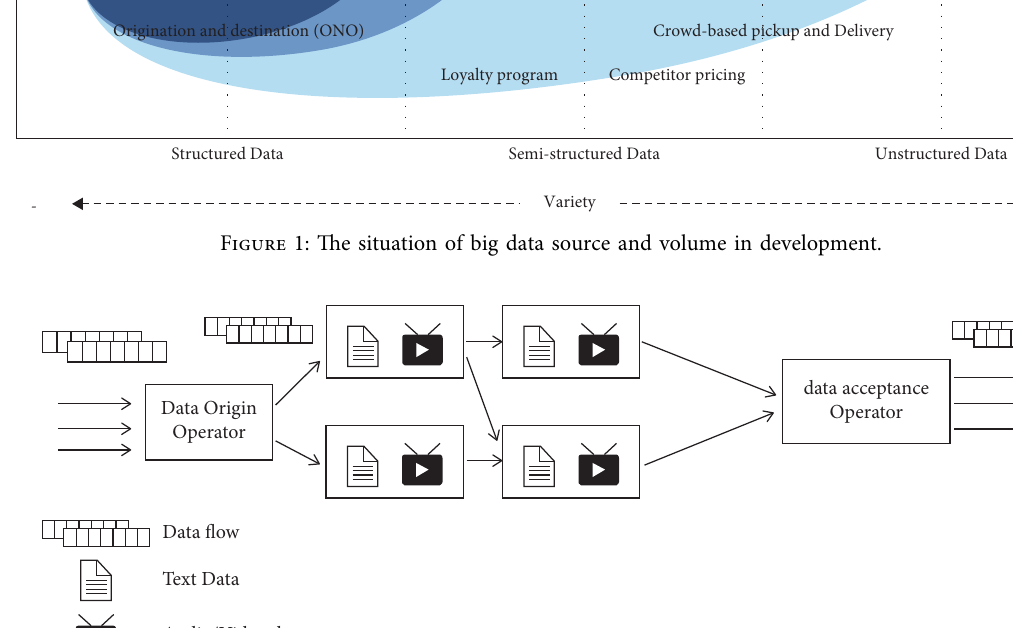
Figure 2: Abstract model of teaching data dynamic generation and service